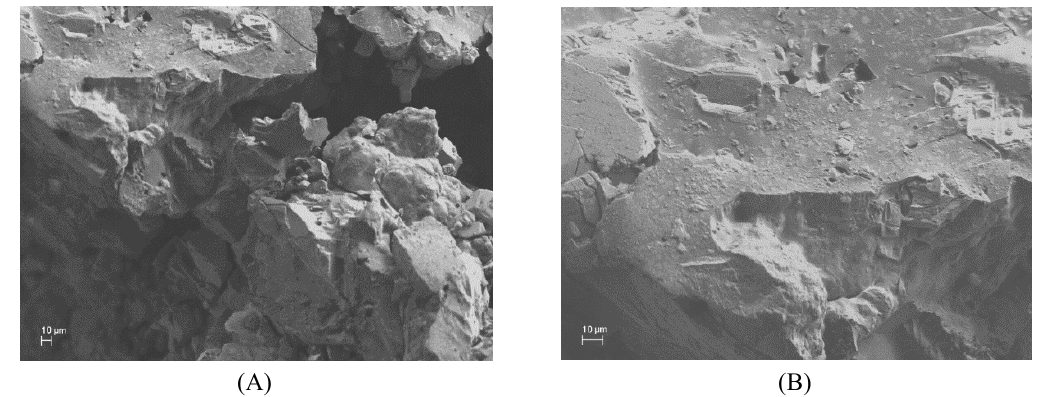
Figure 5. SEM images of cross-linked β -CD-EPI empty polymer ( A ) and laden with Direct Red 83:1 ( B ).